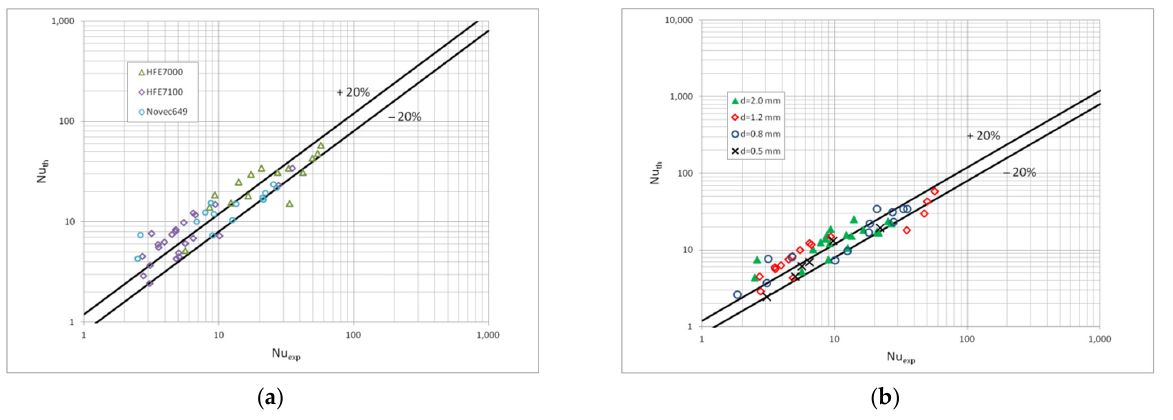
Figure 12. Comparison of the experimental investigation results of the HFE7000, HFE7100 and Novec649 refrigerants condensation in mini-channels which calculation according to the correlation (1) for the intermittent flow; ( a ) for individual refrigerants, ( b ) for individual mini-channel diameters.